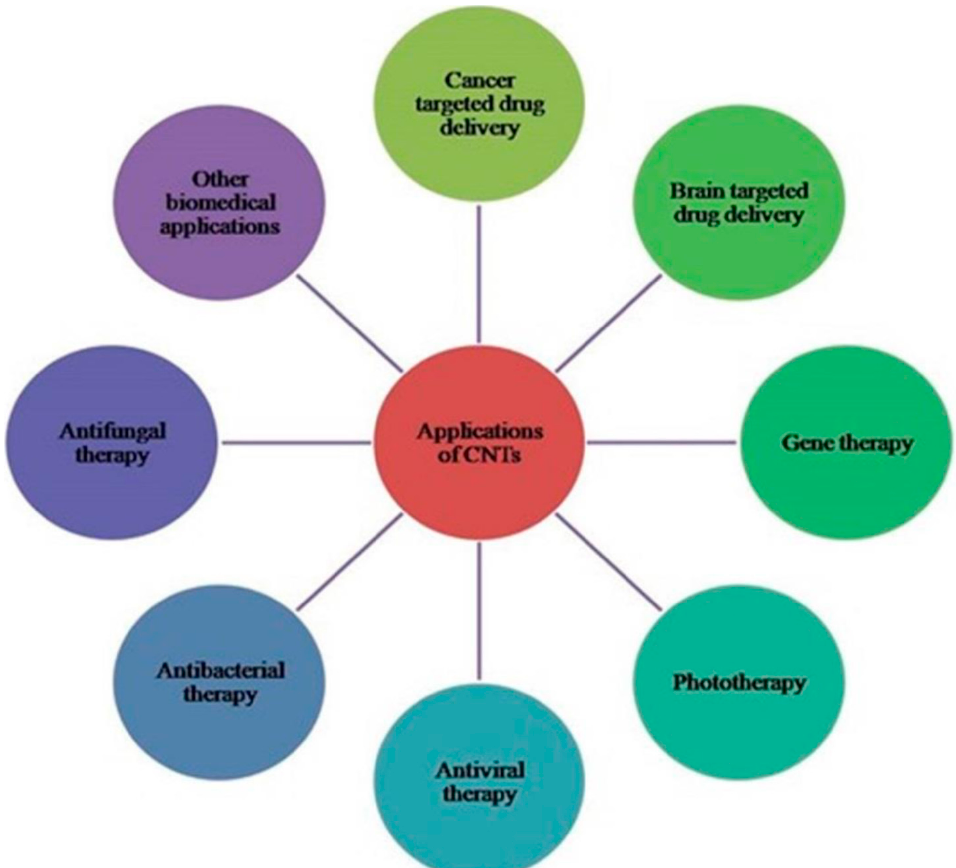
Figure 8. Diverse applications of CNTs.